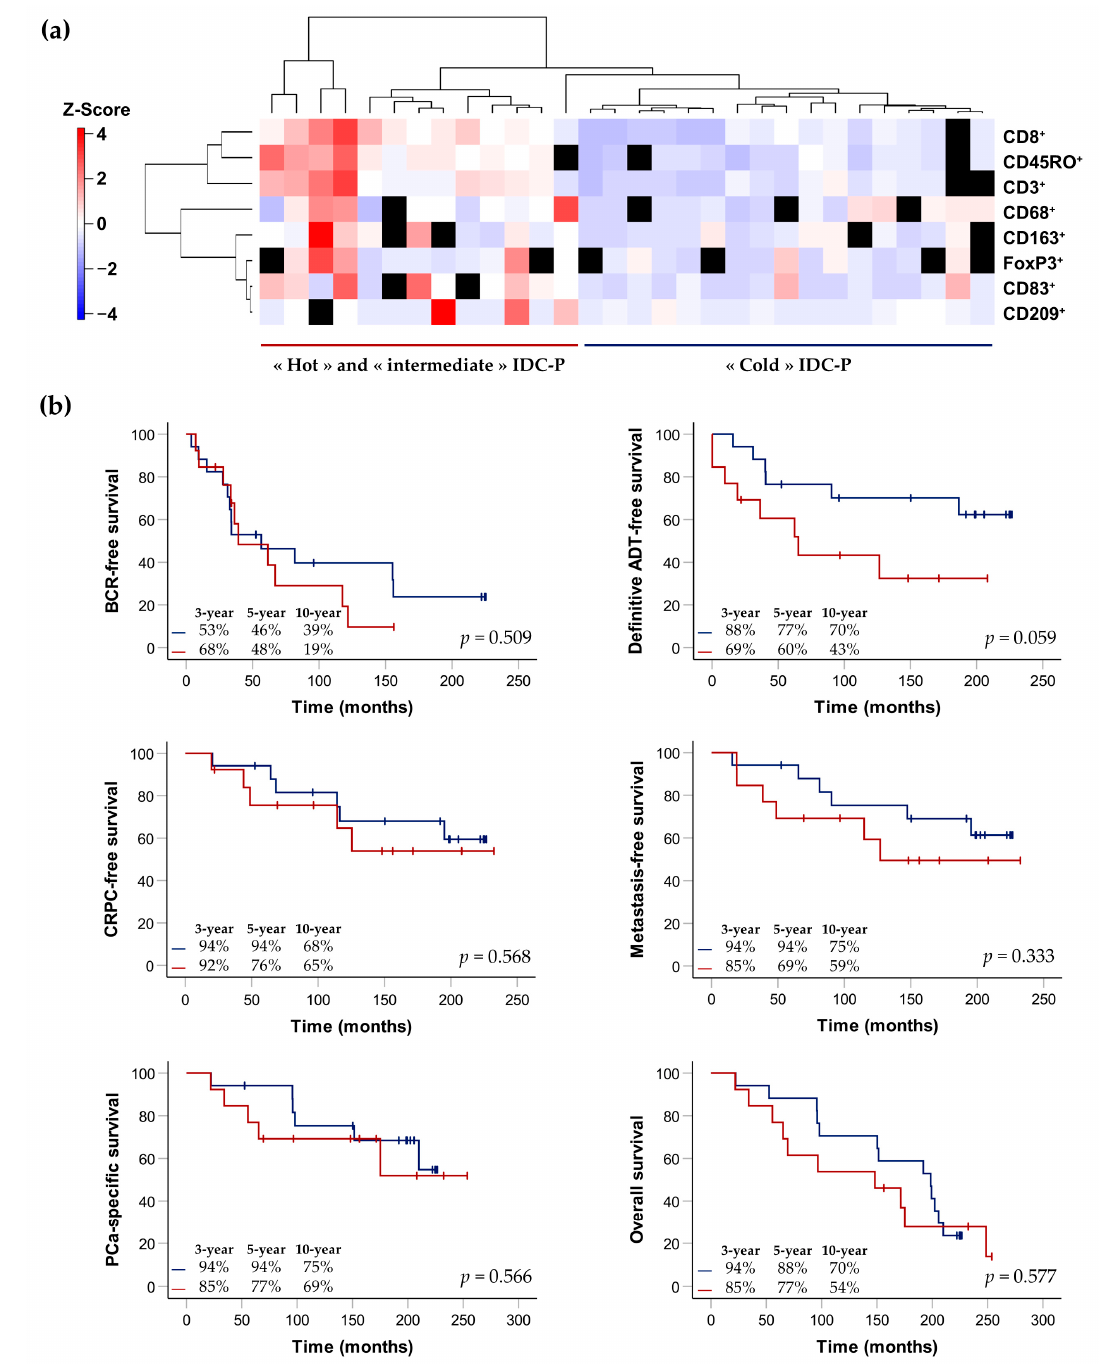
Figure 6. Hierarchical clustering of the eight immune-cell markers according to average cell densities in the total IDC-P ( a ) and Kaplan–Meier curves exploring survival rates of patients with immunologically “cold” IDC-P (blue) and patients with immunologically “hot/intermediate” IDC-P (red) ( b ). ( a ) On the left side: cell-density scale from dark blue (low) to dark red (high). Each row corresponds to a patient and missing slides/quantification data are represented by black squares. The IDC-P-positive patients with more than three missing quantification data were excluded, bringing the total number of patients to 30. ( b ) The p -values were calculated using the log-rank test. Three-, five- and ten-year survival rates are indicated in the bottom left of each graph. ADT: androgen-deprivation therapy; BCR: biochemical recurrence; CRPC: castration-resistant prostate cancer; IDC-P: intraductal carcinoma of the prostate; PCa: prostate cancer.